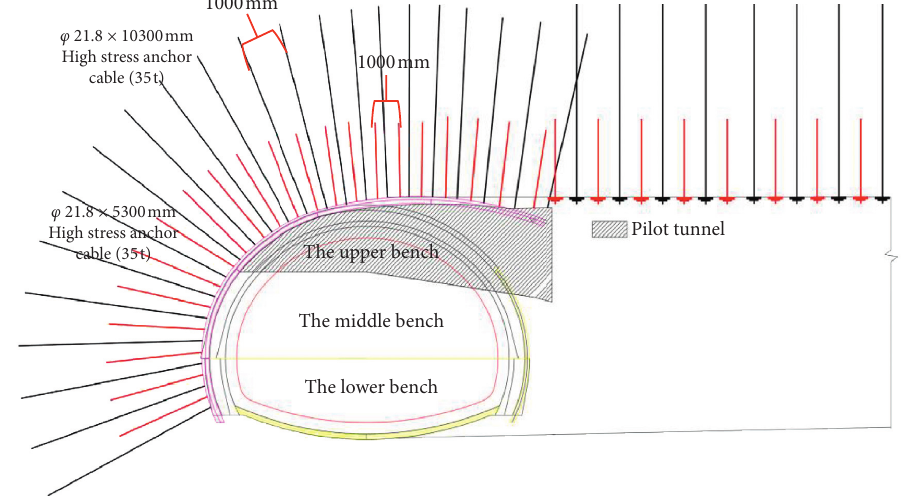
Figure 13: Cross-section of the intersection support scheme layout (A-A ′ ).